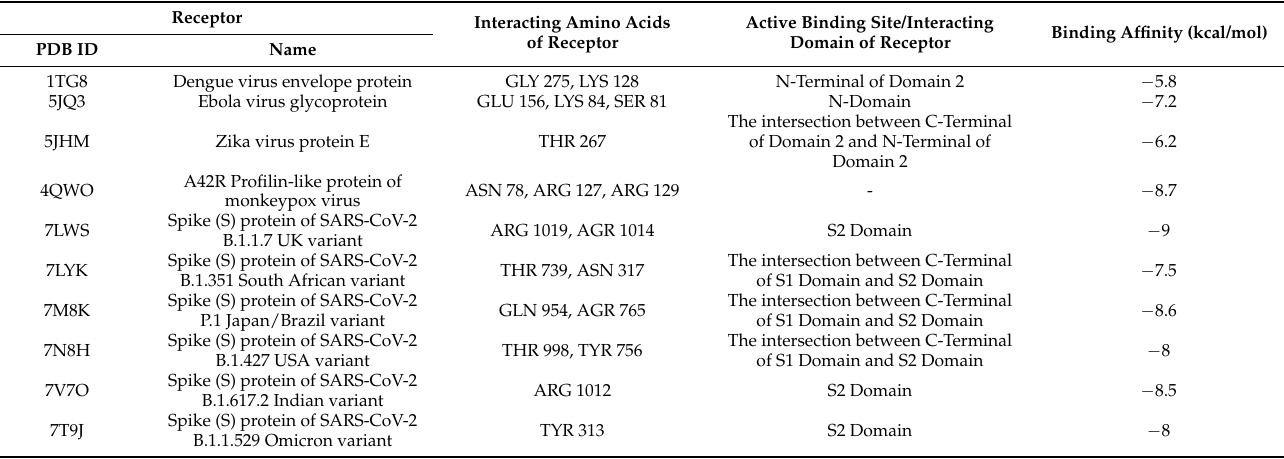
Table 11. Molecular docking analysis of lyngbyabellin A (CID:10032587). Receptor